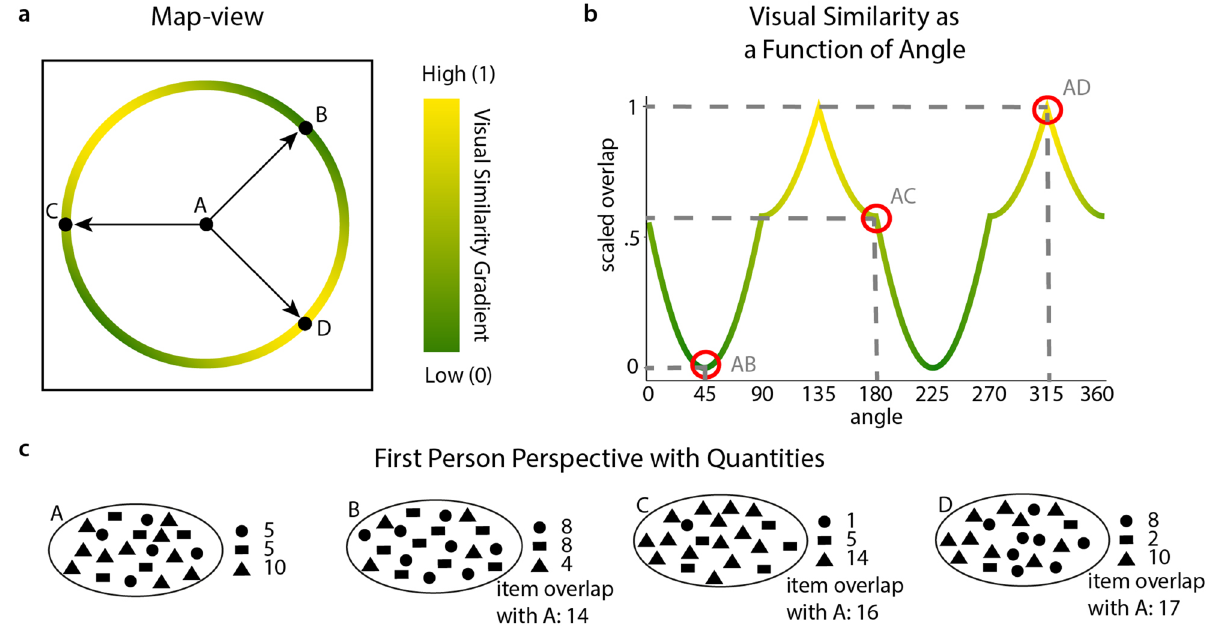
Figure 3. Visual similarity. ( a ) Map-view. Representation of the space as given in Fig. 1. Shown are four positions, A, B, C and D. Positions B, C and D have the same distance to A. The circle on which they lie shows the angle dependent visual similarity distribution in a colour gradient from yellow (high visual similarity) to green (low visual similarity). B has the lowest visual similarity to A, D has the highest. ( b ) Visual similarity as a function of angle. Visual similarity was calculated for all positions on a circle with radius 100 conceptual meters and the center position (as in the example in ( a ) between A and all positions on the circle around it including B, C and D) by calculating the total amount of items shared between the positions. This distribution was then scaled to range between 0 (lowest visual similarity) and 1 and expressed as a function of angle. Items shared are independent of the colour code that was used to encode direction (i.e. the red to blue scale). Highlighted are the visual similarities for the angles AB, AC and AD. ( c ) Down-sampled (5%) representation of the first-person perspective when standing at the locations A, B, C and D as presented in ( a ). For this illustration we excluded the colour code, since all tasks that measure visual similarity controlled for colour. Visual similarity was thus both independent of distance as well as of colour and can be purely described as a function of angle (as in b ). For each position we included the quantities of items. Here visual similarity as total item overlap is given in respect to A for positions B, C and